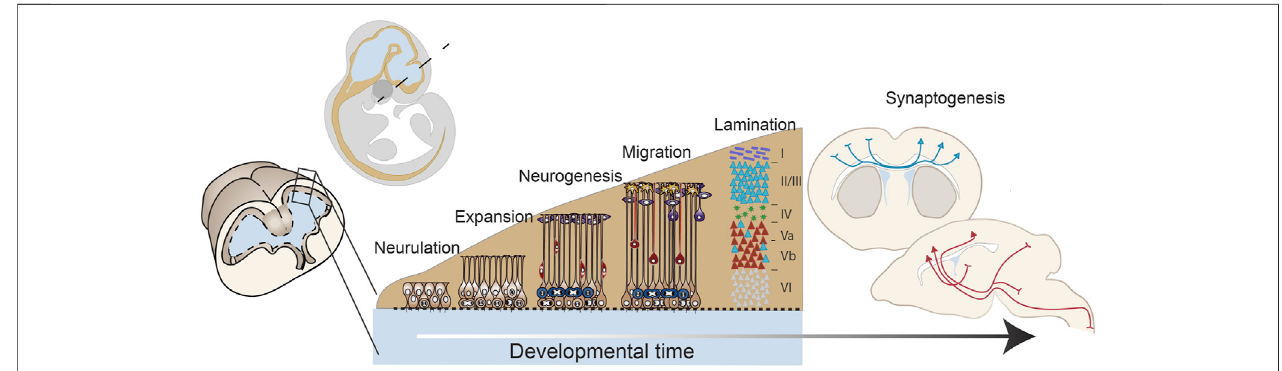
FIGURE1| Earlyforebraindevelopment:fromneurulationtomid-corticogenesis.Adevelopmentaltimelineoutliningthemajorstagesofforebraindevelopmentthat will be discussed in this review including: neurulation, progenitor expansion, neurogenesis, migration and lamination, and connectivity and synaptogenesis. These drawings are based on mouse brain